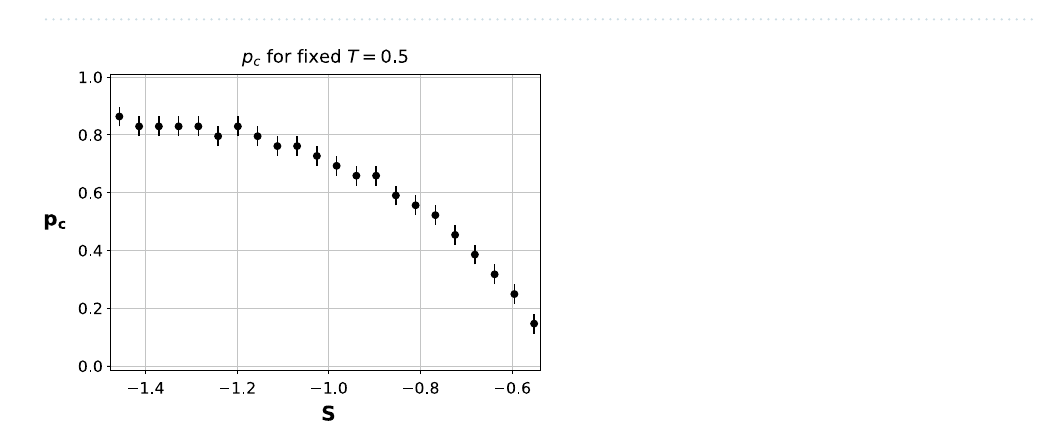
Figure 7. ( a – h ) ( S , T ) diagrams showing the average value of α for different choices of p . ( i ) Summary of the green-yellow transition lines obtained for different choices of p .